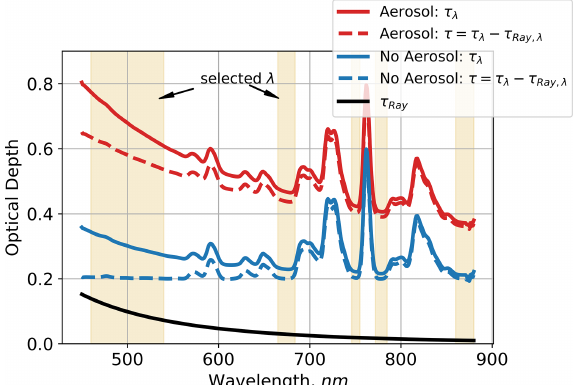
Figure 1. Simulated spectral τ λ for two cases. Cloud only ( τ cld = 0 . 20, τ aer,500nm = 0 . 00) is denoted by the blue lines, and a case with cloud and aerosols ( τ cld = 0 . 20, τ aer,500nm = 0 . 38) is shown by the red lines. The solid black line is calculated τ Ray ,λ . Subtract- ing τ Ray ,λ from τ λ yields the dashed red and blue lines, which are represented by Eq. (7). The shaded yellow regions are the wave- lengths selected for use in RS. For the aerosol-free case, the layer optical depth is spectrally flat at the value of τ cld